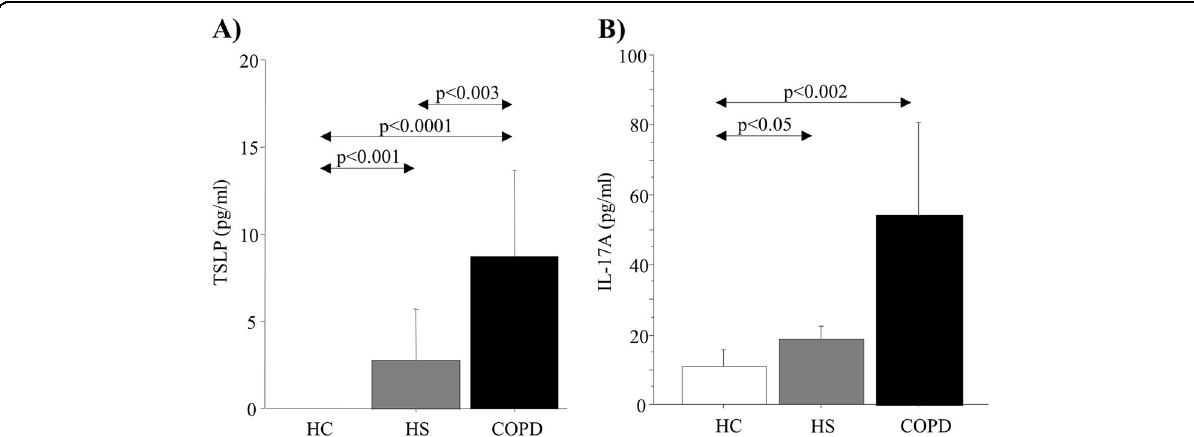
Fig. 1 TSLP and IL-17A concentrations in ISs from HC ( n = 10), HS ( n = 10), and COPD patients ( n = 12). a TSLP levels (pg/mL) and b IL-17A levels (pg/mL) were measured using speci fi c commercially available kits as described in the “ Materials and methods ” section. Two technical replicates were performed. The bars represent the mean ± SD of the values (pg/mL). Statistical analysis was performed using the Kruskal – Wallis test followed by Bonferroni – Dunn correction for multiple comparisons. A p value < 0.05 was considered statistically signi fi cant